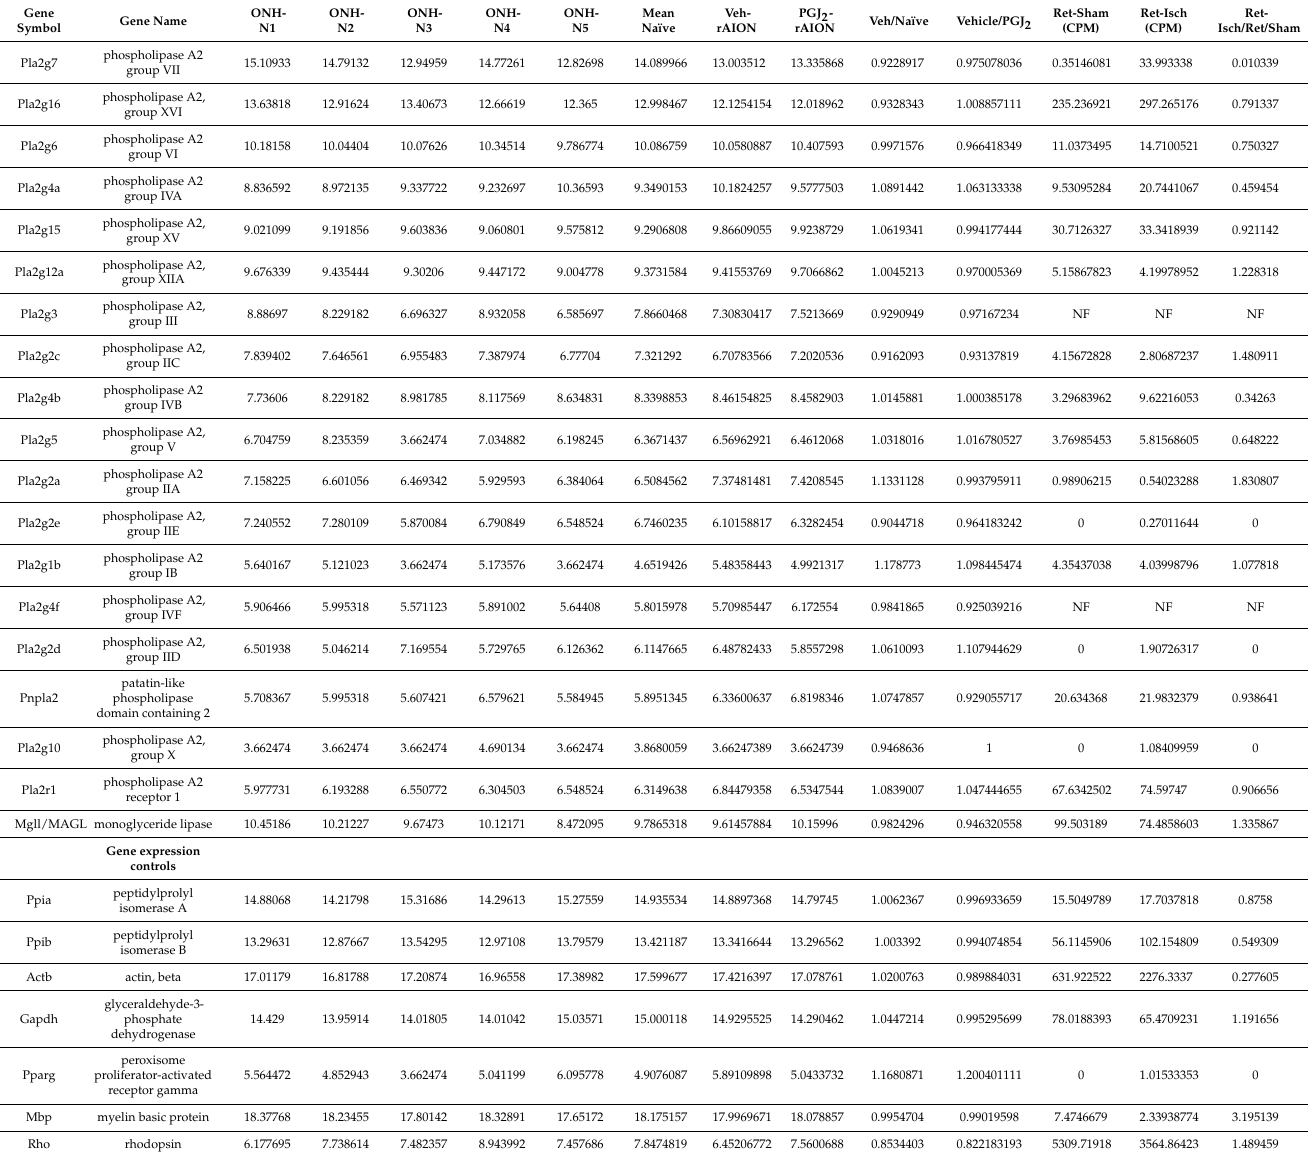
Table 3. List of arachidonic acid synthetic genes: phospholipase A2 genes and MAGL/MGLL. Illumina sequence data for ONH are based on Deseq2-normalized (log 2 -fold relative levels) expressed in ONH RNA from naïve, rAION-vehicle- induced and rAION-PGJ 2 -treated animals, using a cutoff of <3.4. Normalization is based on Trimmed Mean Values (TMM) and normalized by EdgeR-cpm function with a cutoff of 2. Naïve retina (retina-N) and ischemic retina (retina-Isch) are from [19] and expressed in counts per million (CPM). The ratio of expression in ischemic retina/sham retina values are shown in the last column. Gene-mRNA quantification and differential expression can be equated between the two studies (ONH and retina) by comparing the relative expression of both standard housekeeping genes (Beta-Actin (Actb), cyclophilin a ((ppia), cyclophilin b (ppib), glyceraldehyde phosphate dehydrogenase (GAPDH) and PPAR γ (pparg), as well as the expression of some of the highest expressing genes in each tissue (MBP in ONH; Rho in retina). NF: not